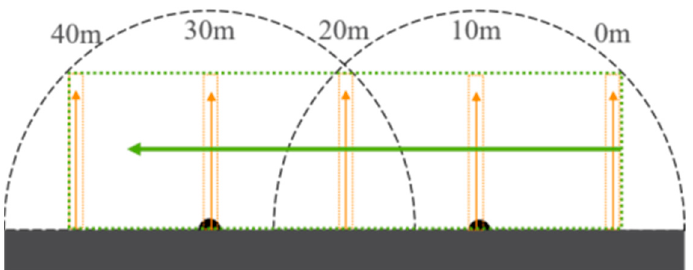
Figure 3. Berthing Assistant System Concept. LiDAR sensor positions shown as dots and their detection range in semi circles. Vertical Reference Points measure the distance in relation to quay wall. Horizontal Reference Points shown in green measure the distance to meter mark zero.